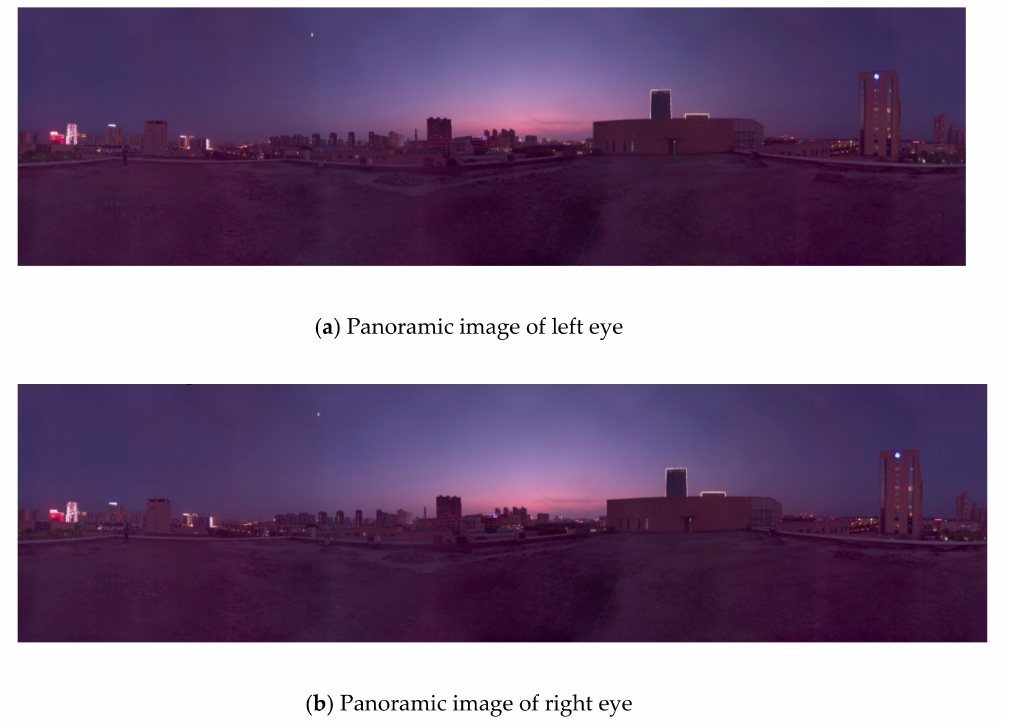
Figure 20. The left ( a ) and right eye ( b ) compose a stereoscopic panorama in weak light.